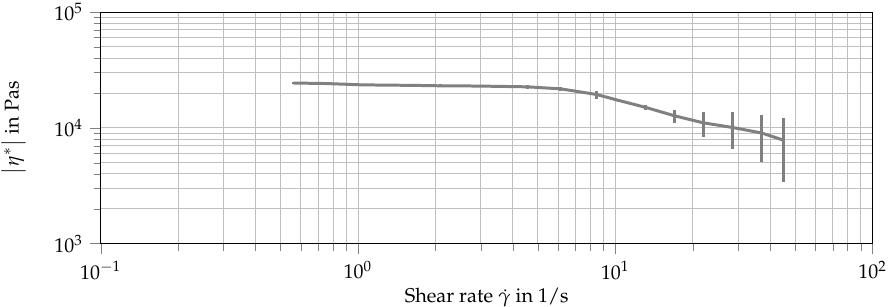
(cid:12) (cid:12) (cid:12) η ∗ (cid:12) of three frequency sweeps vs. shear